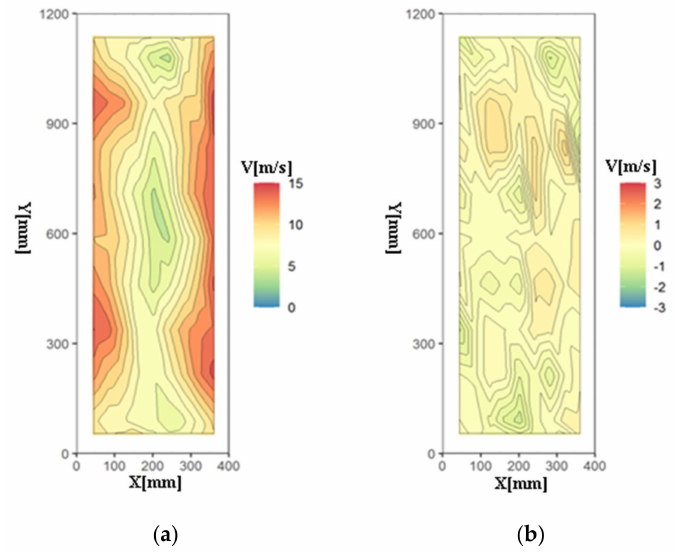
Figure 7. Velocity map; ( a ) with single-segment rotor; ( b ) difference between a single-segment and four-segment